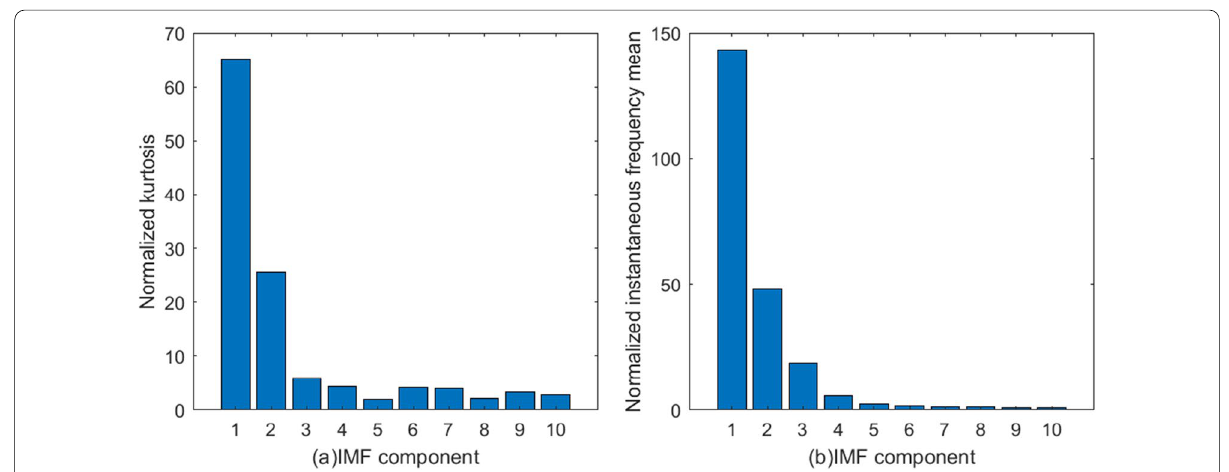
Fig. 7 Normalized kurtosis/instantaneous